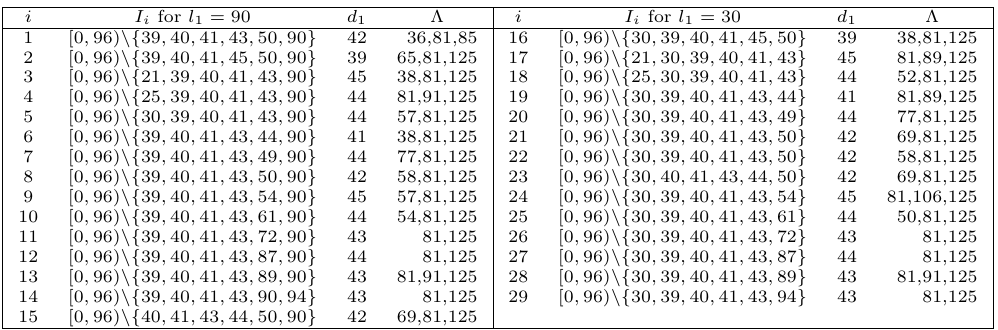
Table 3: The qualified 90-dimensional cubes used for attacking 256-round Grain-128. The nullification strategy is N S = { ( l 1 , b 158 ) } where l 1 = 90 for I 1 , . . . , I 15 and l 1 = 30 for the